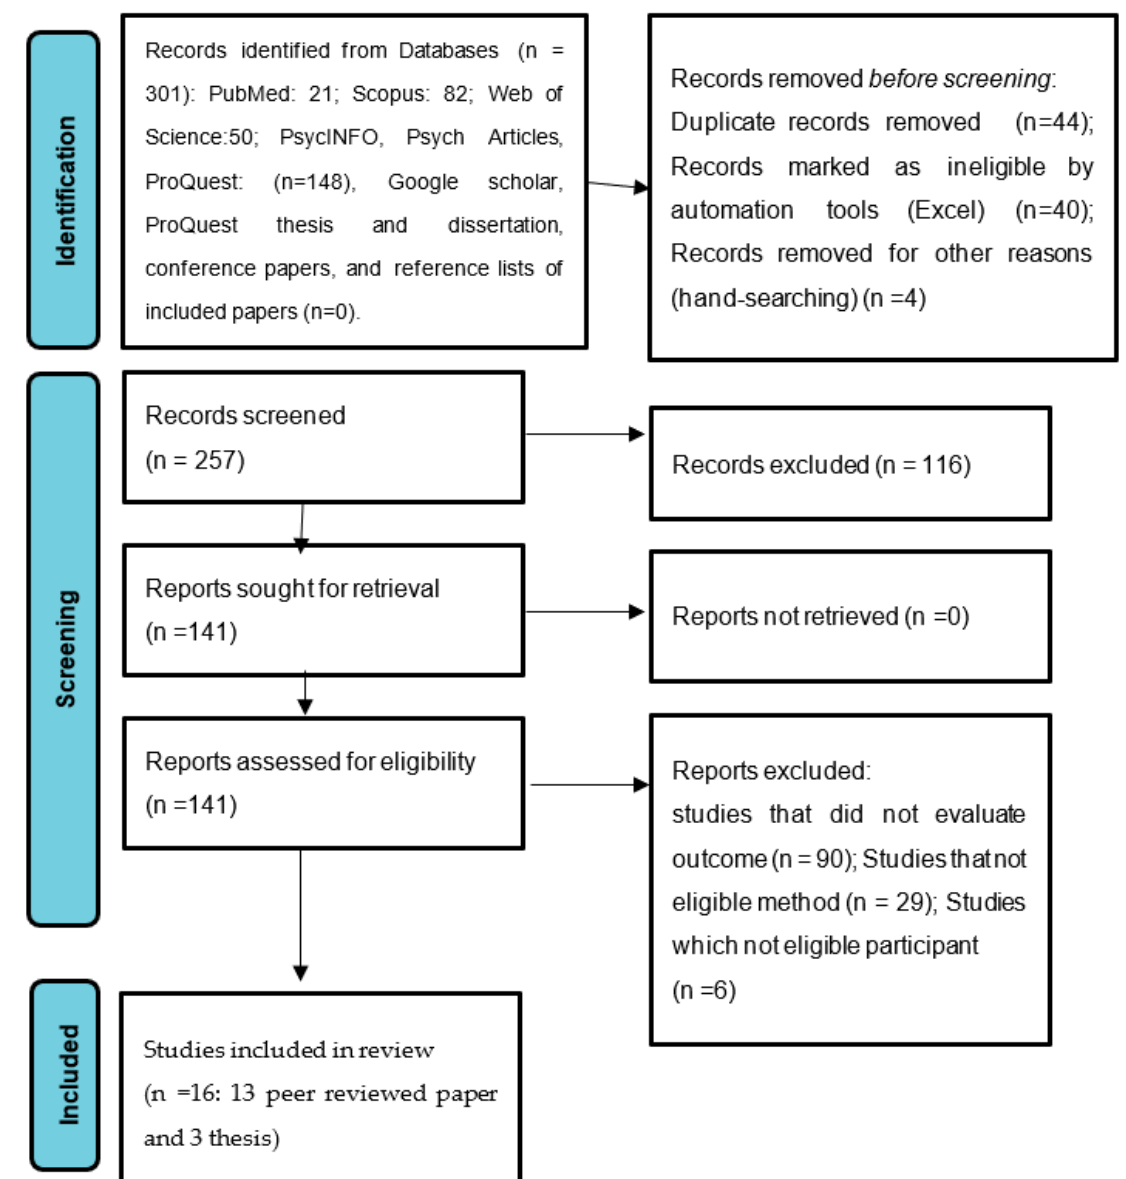
Figure 1. The study PRISMA flow diagram from the search to the selection of eligible studies.